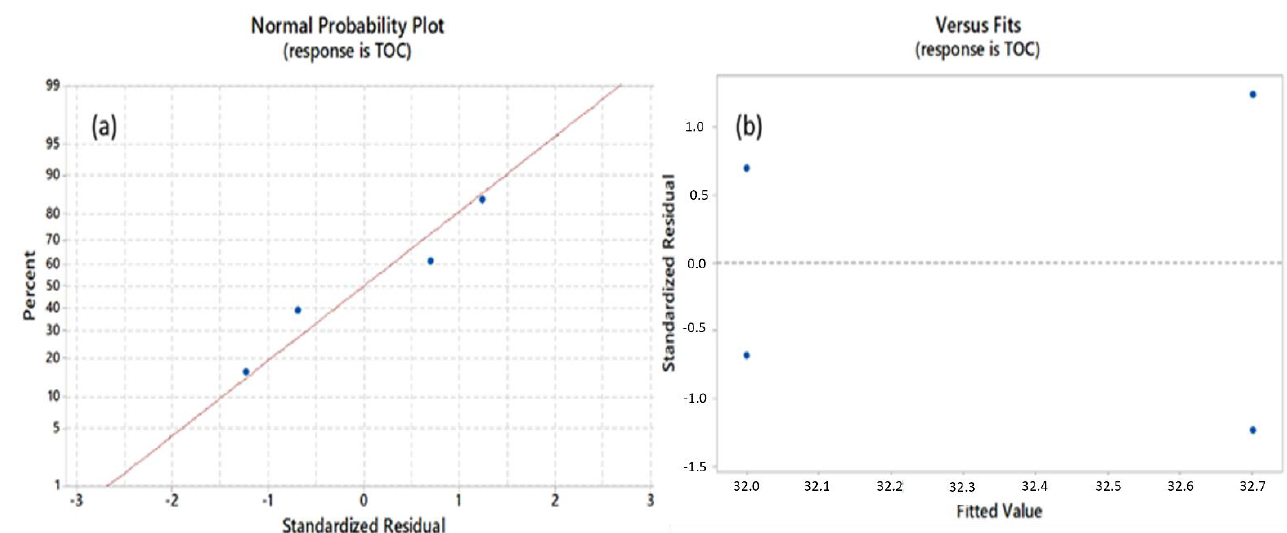
Figure 3. ( a ) Normal probability plot, ( b ) residual versus the fitted value of the data after CFD process, with TOC as response.